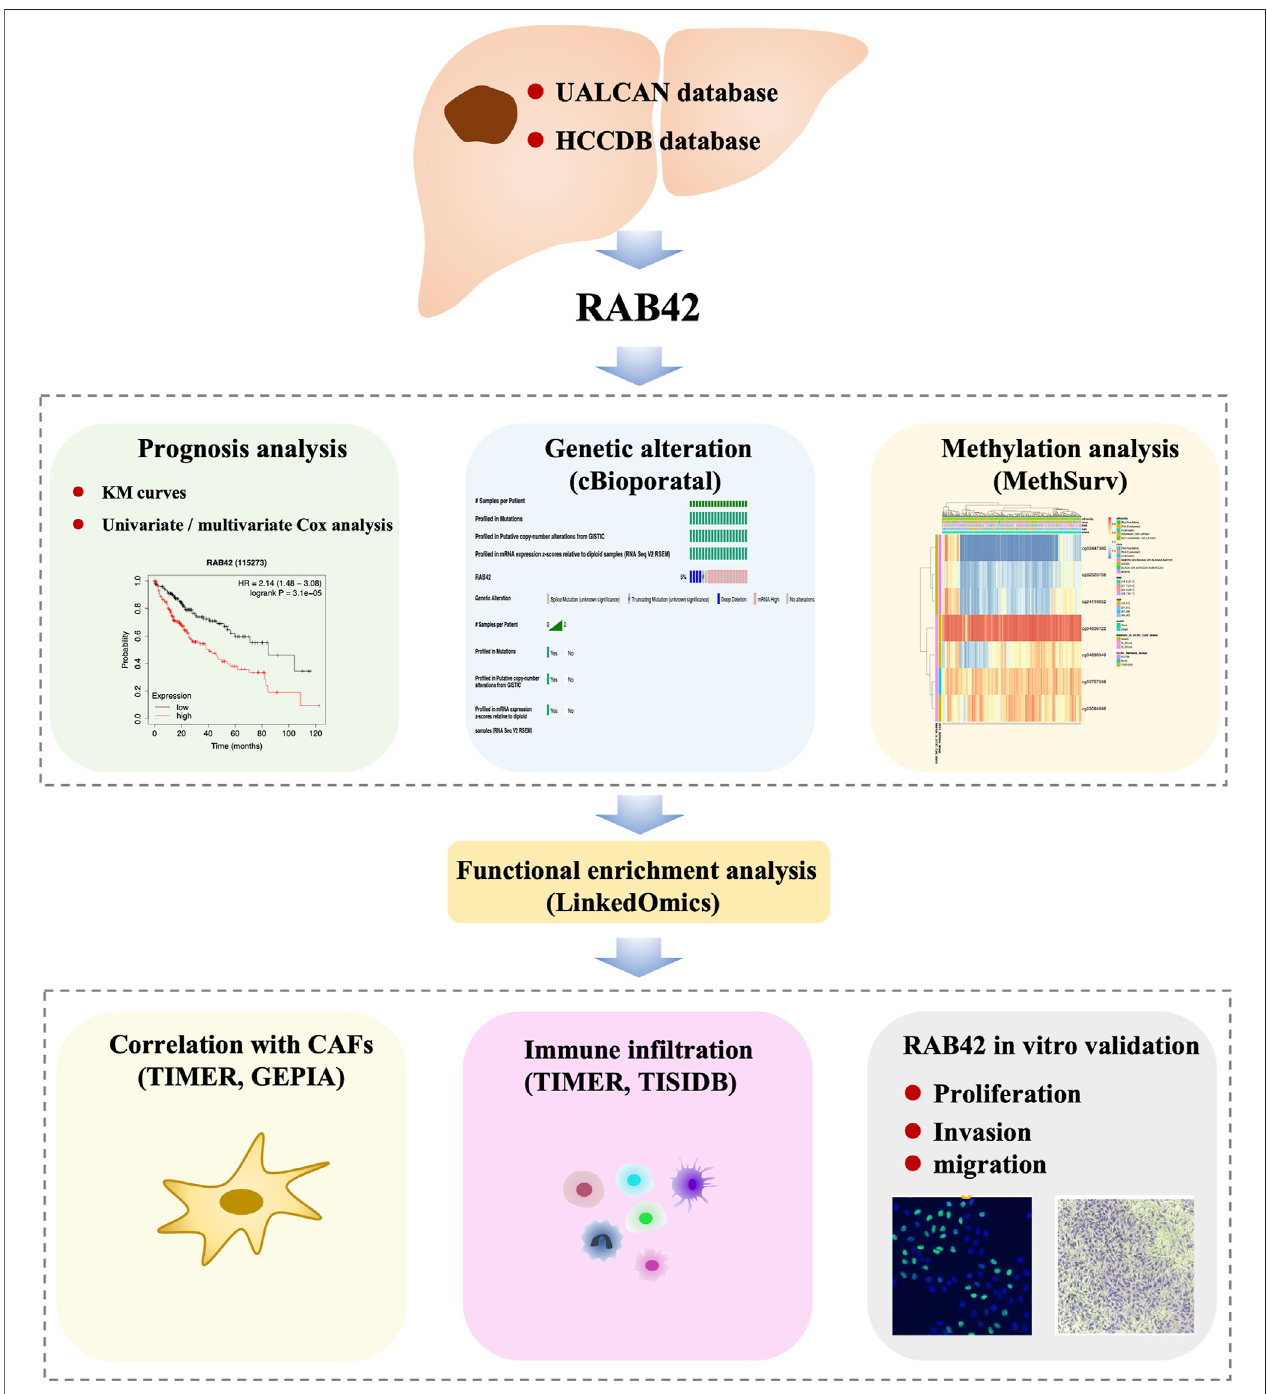
FIGURE 1 | Work fl ow of this